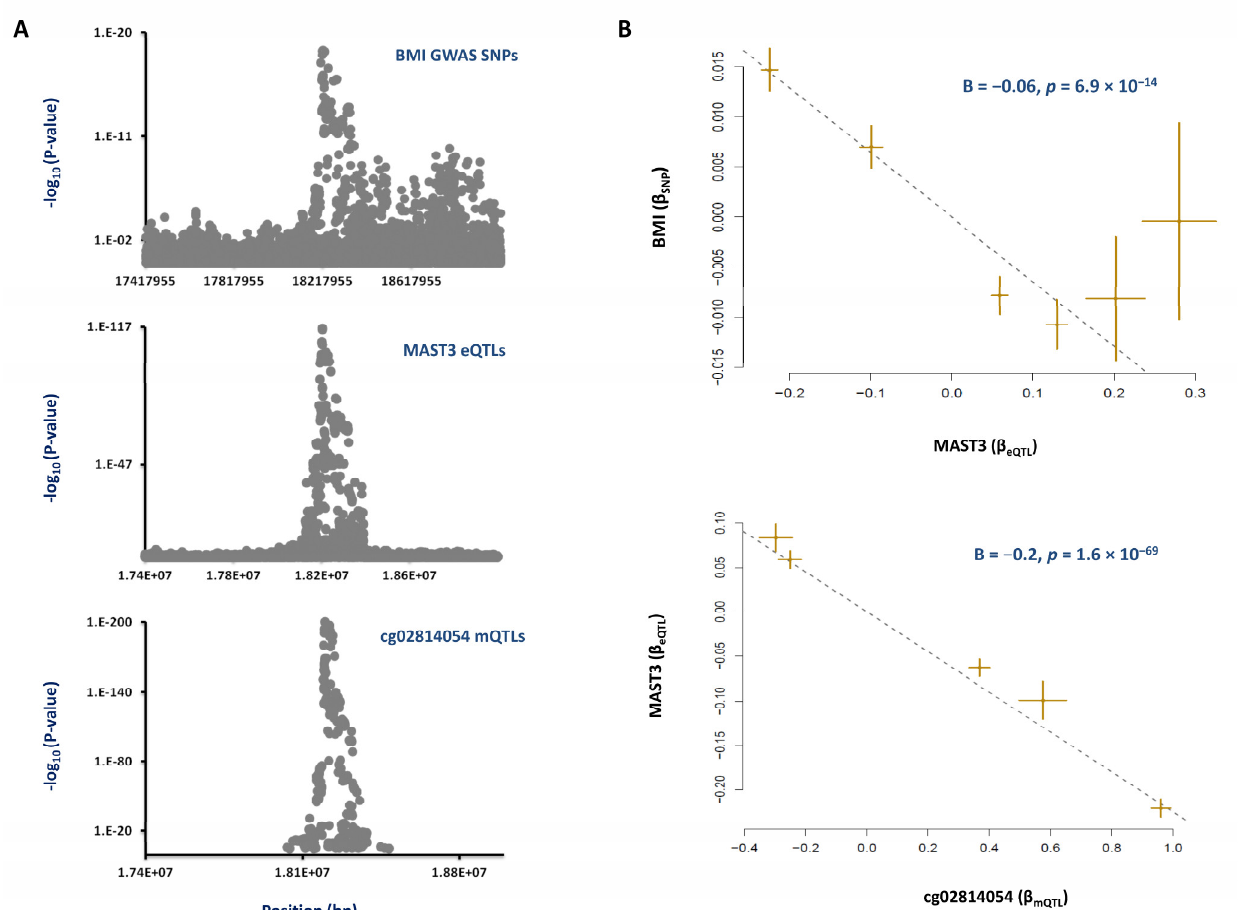
Figure 4. Mechanism whereby the cg02814054 site inside MAST3 impacts obesity. ( A ) We found that the regional association plots for mQTLs of cg02814054, eQTLs of MAST3 and risk SNPs of obesity co-localize. ( B ) MR analysis then revealed that, as the cg02814054 site becomes hypermethylated, the expression of MAST3 decreases, and this contributes to a higher BMI. Each point on MR plots represents a SNP; the x-value of a SNP is its β effect size on the exposure, and the horizontal error bar represents the standard error around the β. The y-value of the SNP is its β effect size on the outcome, and the vertical error bar represents the standard error around its β. The dashed line represents the line of best fit (a line with the intercept of 0 and the slope of β from the MR test).